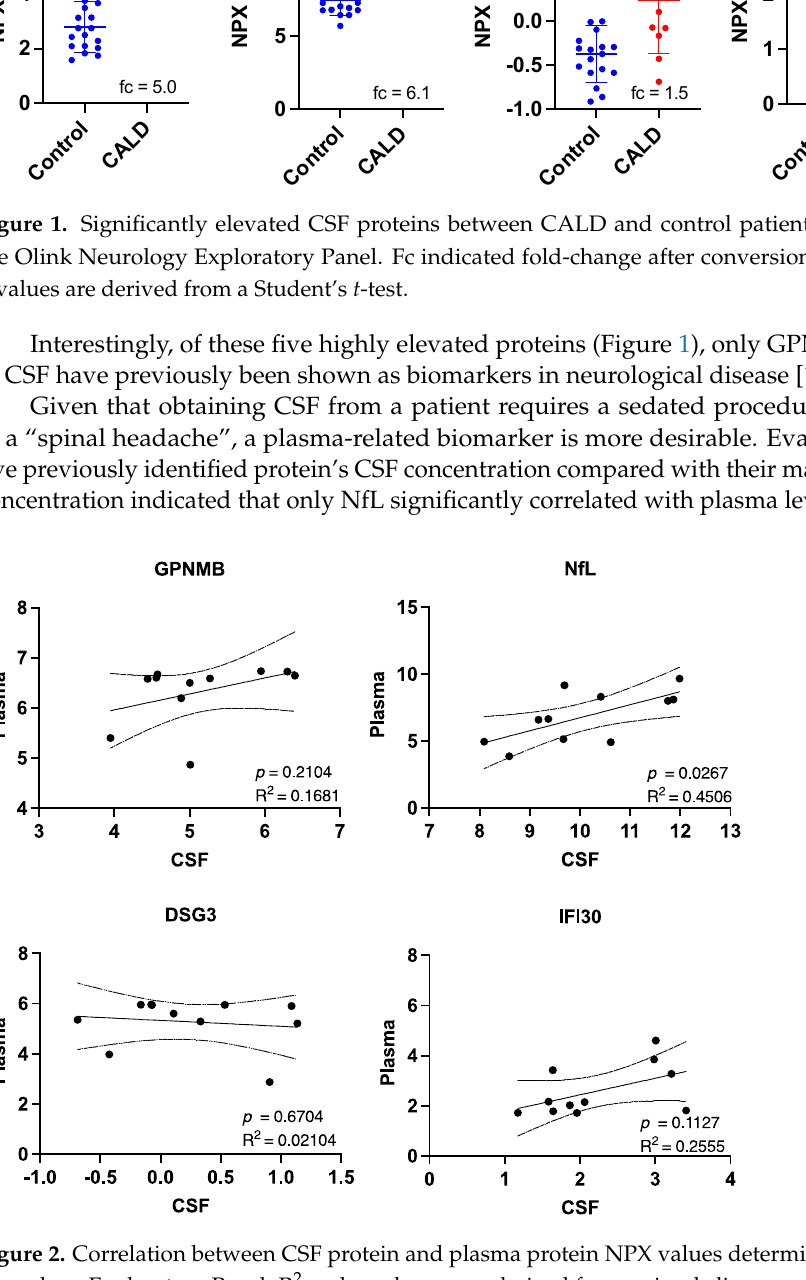
Figure 3. Elevated plasma NfL in CALD patients correlated with cerebral disease level. ( a ) Compar- ison of plasma NfL levels between CALD patients and a pediatric control group. NPX values deter- mined from Olink Neurology Exploratory Panel. Fc indicated fold-change after conversion to linear scale. p -values are derived from a Student’s t -test. ( b ) Correlation between Loes score and plasma NfL. R 2 and p -values were derived from a simple linear regression. Dotted lines indicate the 95% confidence intervals. Eleven patients were assessed pre- and post-HCT. Figure 4a,b shows that 9 of the 11 CALD patients showed decreased plasma NfL levels at 1 year post-HCT, with an overall mean decrease of 50%. Finally, 4 of the patients we assessed had more detailed serial 0